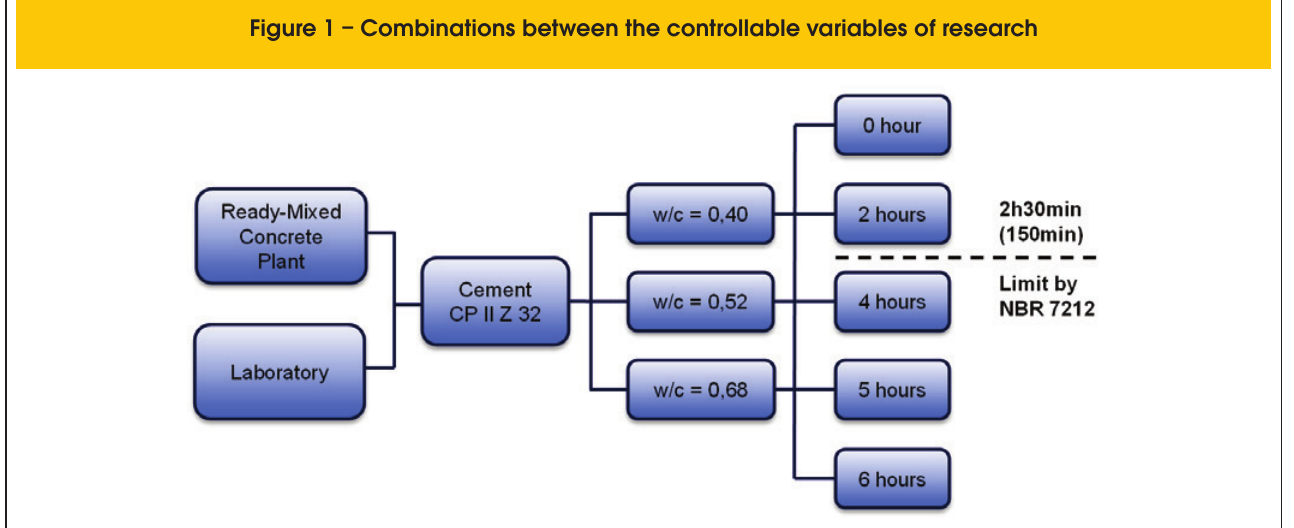
Figure 1 – Combinations between the controllable variables of